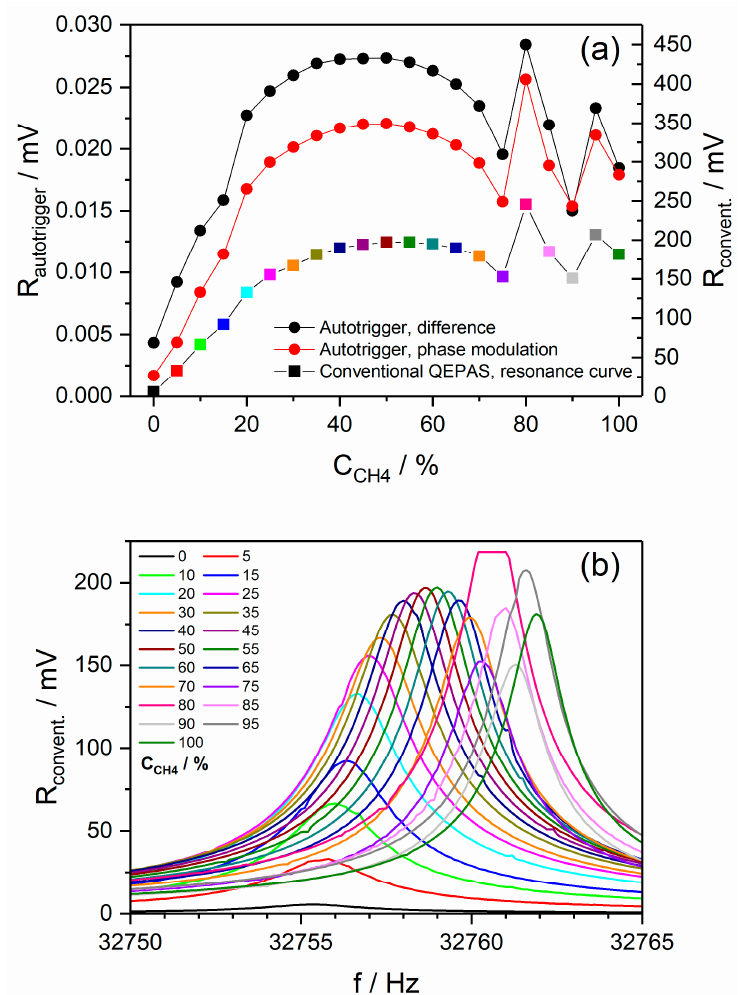
Figure 3. ( a ) Comparison of results achieved with three di ff erent measurement techniques: black dots: autotrigger measurement with fixed phase. The values are derived by subtraction of measurements with blocked laser from those with photoacoustic excitation. Red dots: reading of lock-in amplifier 2 using phase modulation. Colored dots: values extracted from conventional quartz-enhanced photoacoustic spectroscopy (QEPAS) resonance curves given in ( b ) in the respective color. ( b ) Resonance curves for di ff erent mixtures of methane and carbon dioxide.